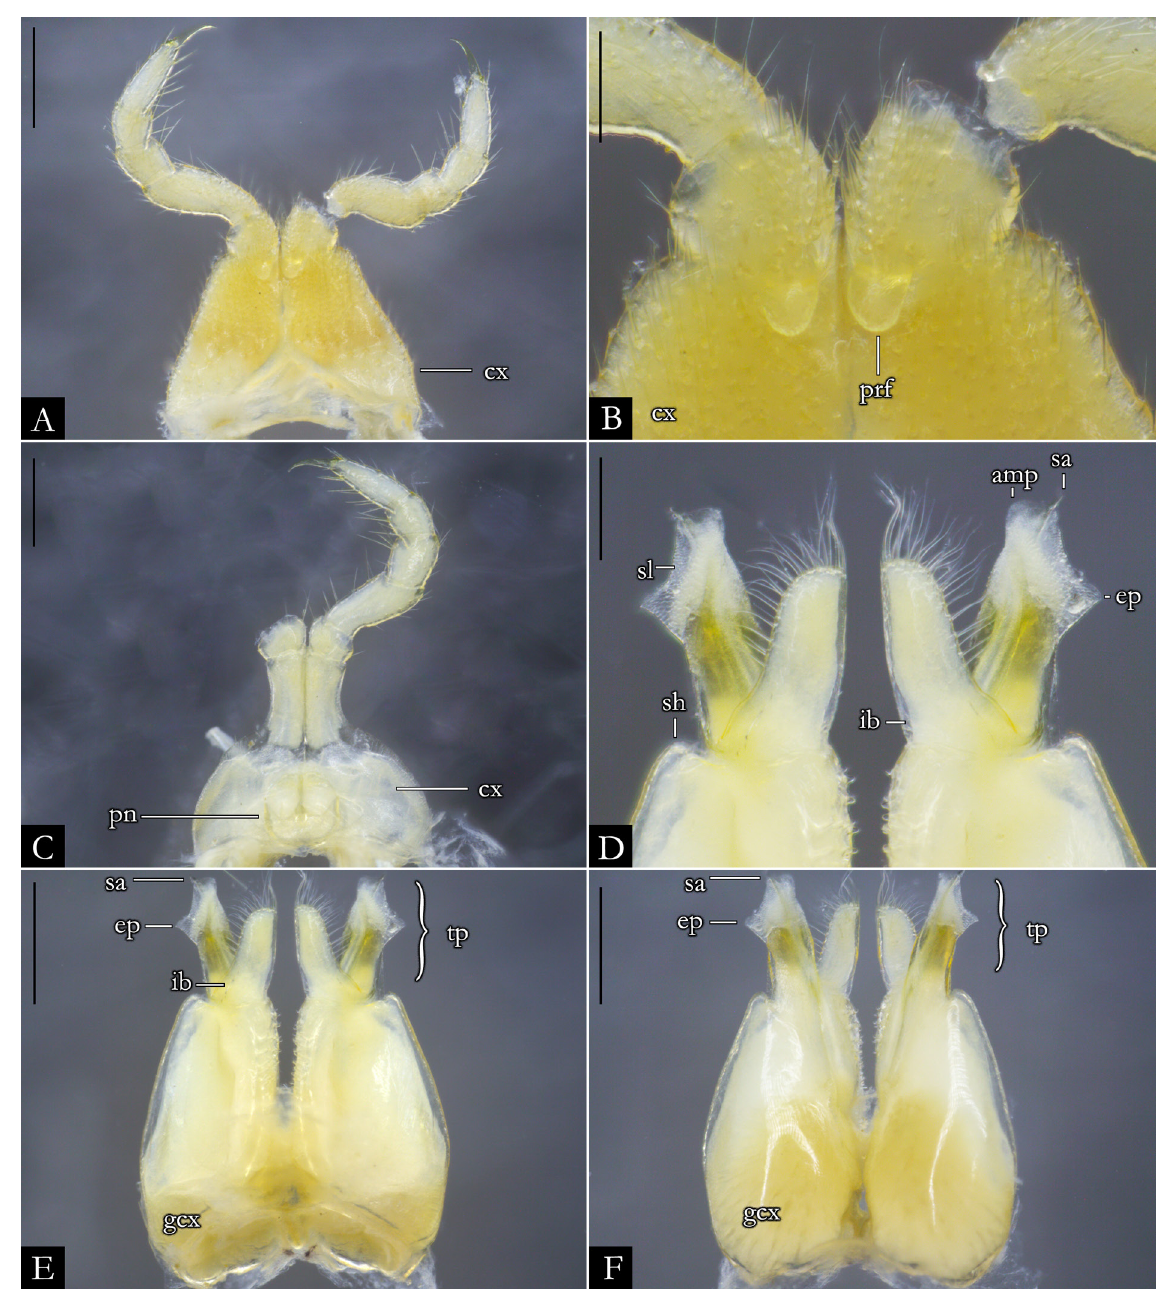
Fig. 124. Pseudonannolene segmentata Silvestri, 1895, ♂ (IBSP 1931). A . First leg-pair. B . Detail of prefemur. C . Second leg-pair. D . Detail of telopodites, in anal view. E . Gonopods, in anal view. F . Gonopods, in oral view. Abbreviations: see Material and methods. Scale bars = 0.5